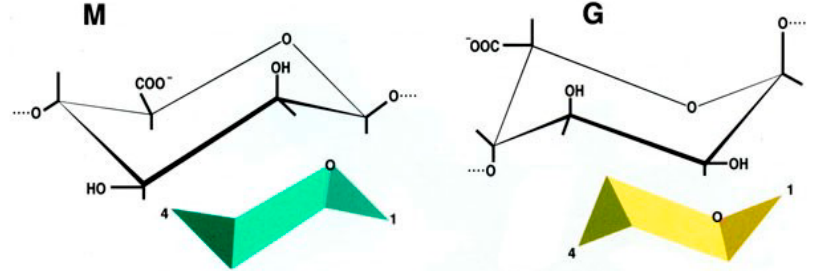
Figure 1. Chemical structure of β - D -mannuronic acid (M) and α - L -guluronic acid (G).